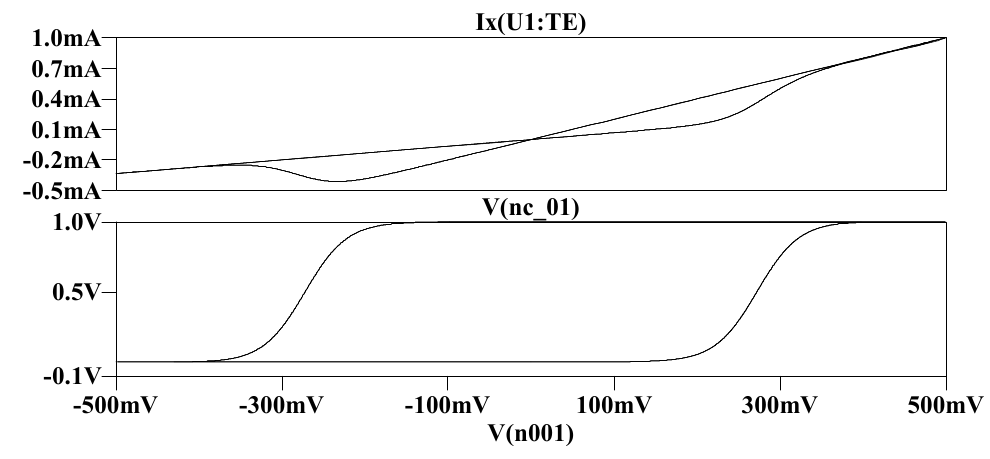
Figure 2. Time domain simulation results: the curve above is the relationship between state variables and time, the sine curve below is the input voltage waveform, and the other curve is the current waveform.